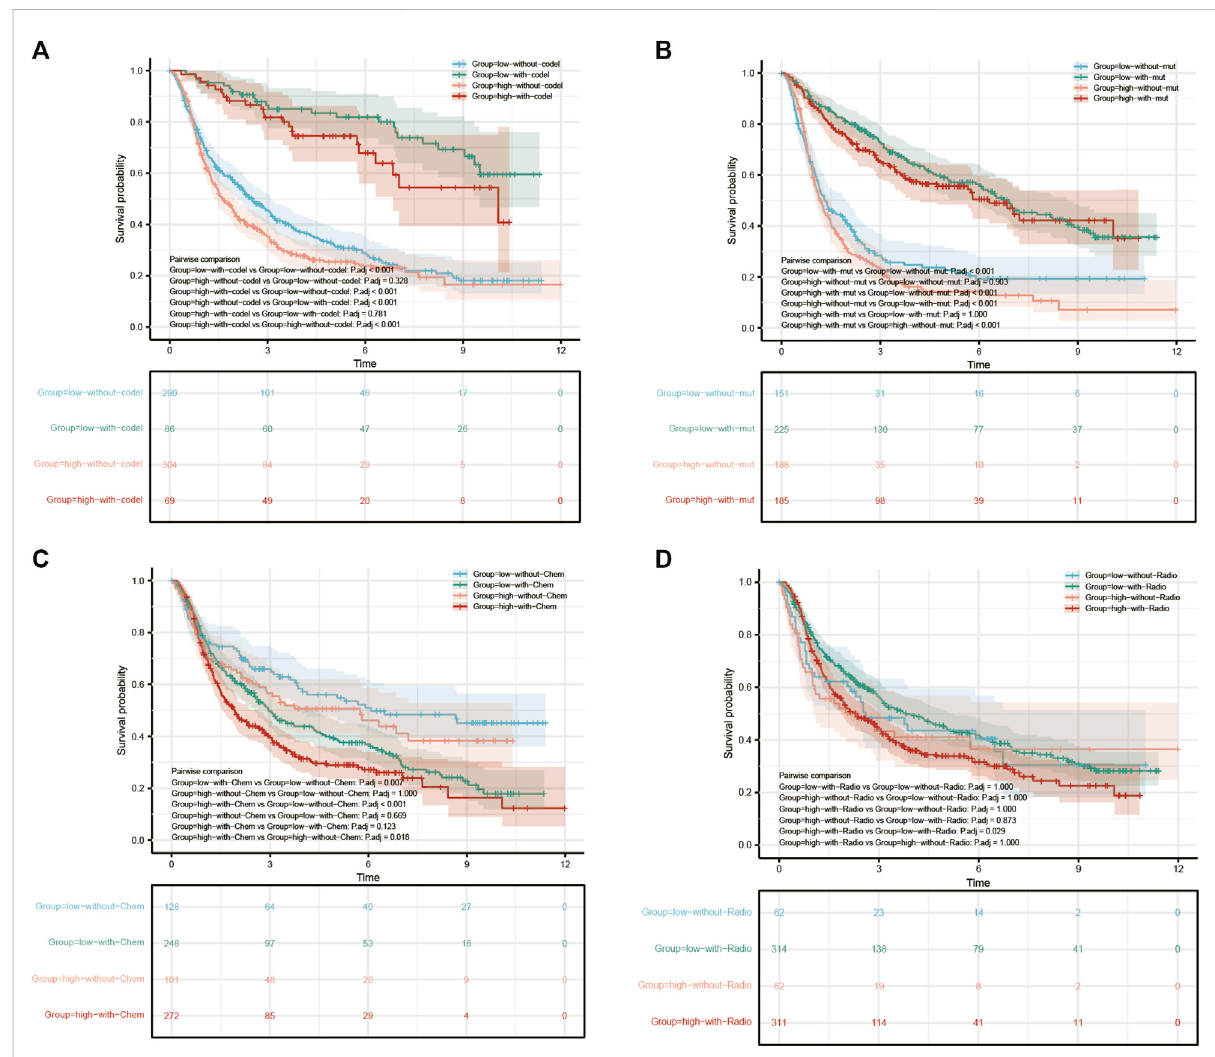
FIGURE 4 SurvivalanalysisofGBMandLGG patientswith varyinglevels ofCOMMD4 expression incomparison with (A) 1p/19q status (B) IDHmutation (C) chemotherapy (D)